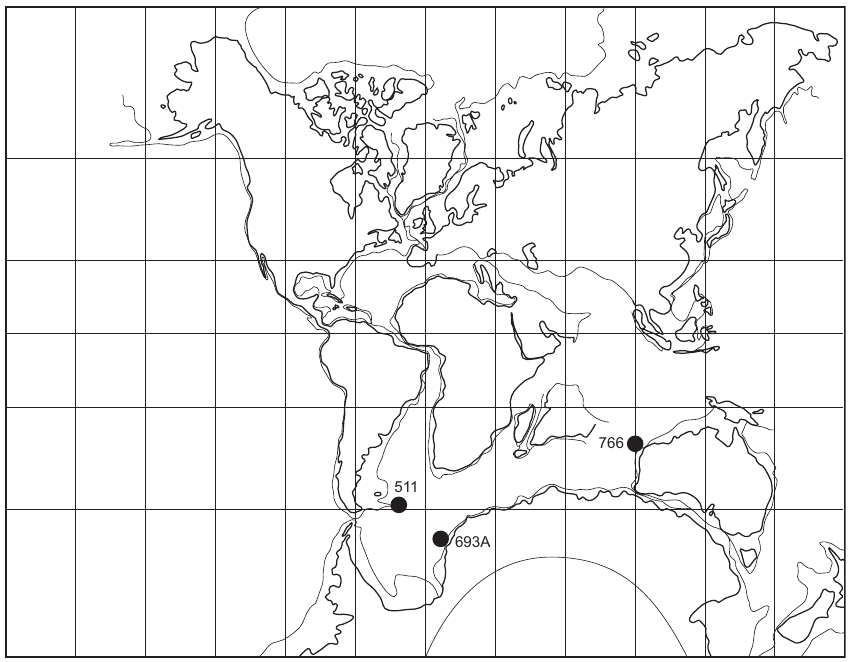
Fig. 1. Map of the mid-Cretaceous world, showing the locations of Site 511 on the Falkland Plateau, Site 693 on the Antarctic shelf, and Site 766 (location includes adjacent Sites 762 and 763) on the Exmouth Plateau, western Australia. Reconstructions after Smith et al. (1981), Mutterlose et al. (2009), O’Connell (1990), Bralower et al. (1994), and Clarke and Jenkyns